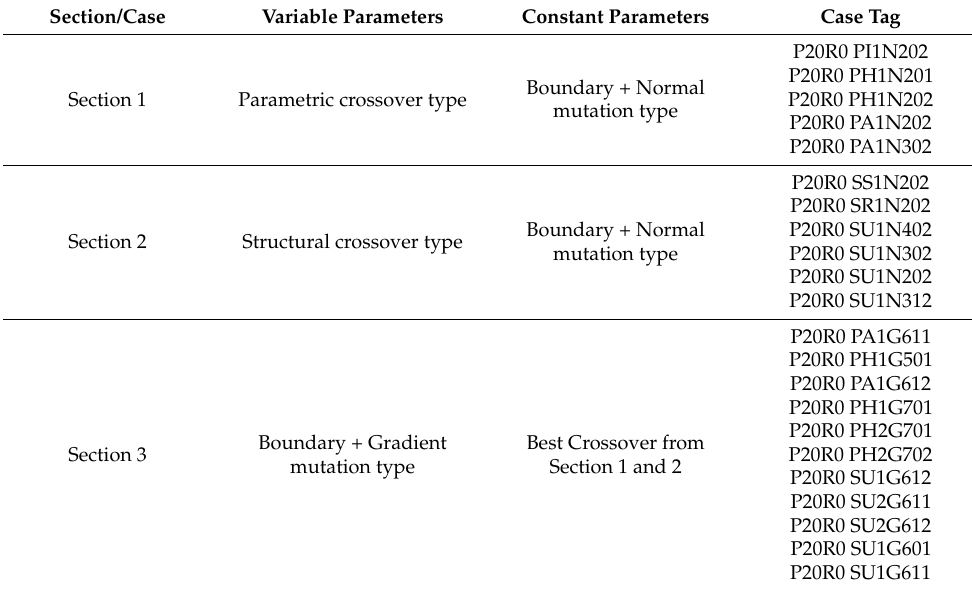
Table 9. Summary of the cases evaluated within analysis